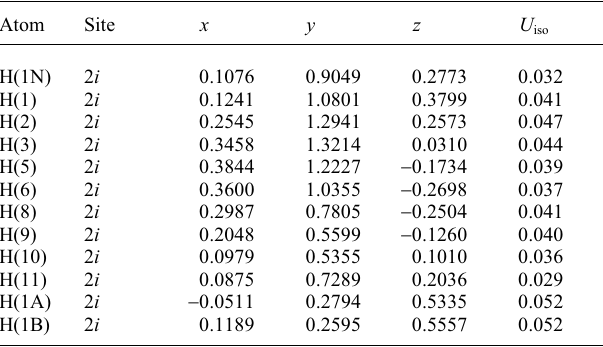
Table 2. Atomic coordinates and displacement parameters (in Å 2 )